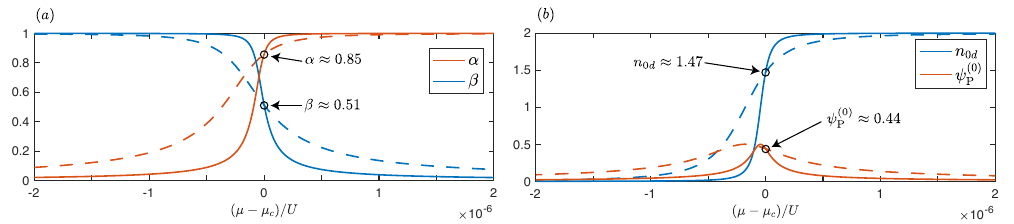
Figure 5: Variation of (a) n in the vicinity of the PSF line at ( µ/ U ) / U = − 0.7. Solid (dashed) lines correspond to the symmetry-breaking offset U 12 η = 10 − 3 ( 2 × 10 − 3 )